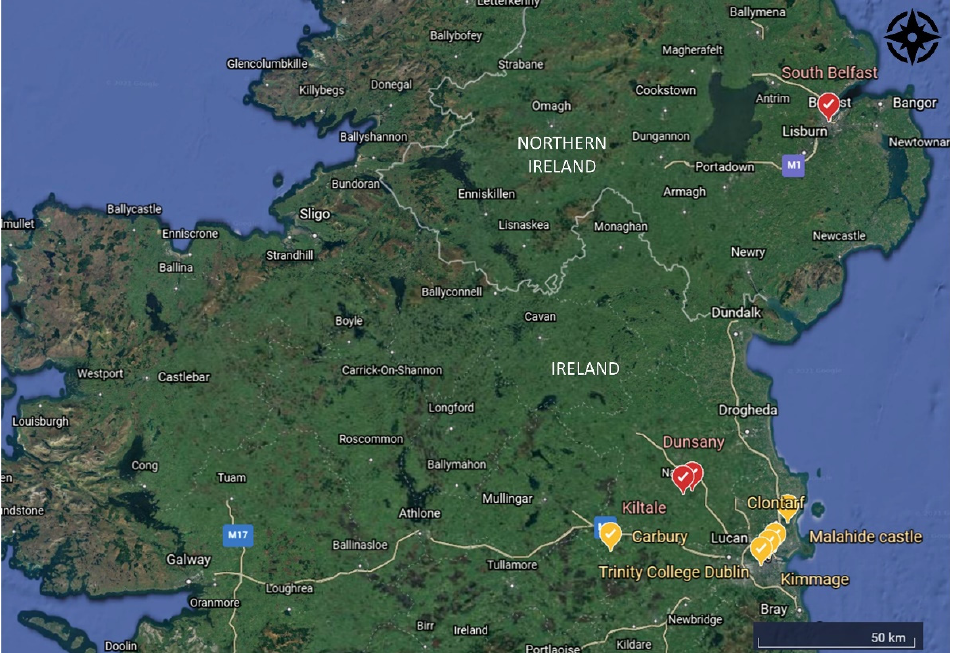
Figure 2. Distribution of observed Fraxinus sp. attacked by T. nigritus in the Republic of Ireland and Northern Ireland. Trees that shown mild defoliation of the crown are marked in yellow, whereas those with severe defoliation are marked in red.